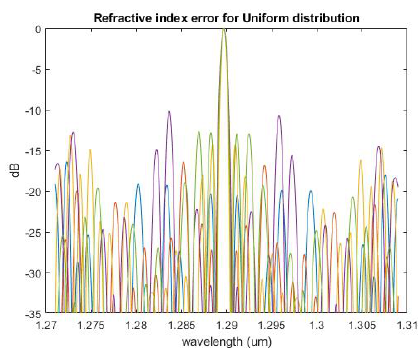
Figure 8. AWG transmission spectrum through the uniform distribution in the waveguide width variation of ± 10 nm. Different color lines represent each random number in the waveguide width variation range.